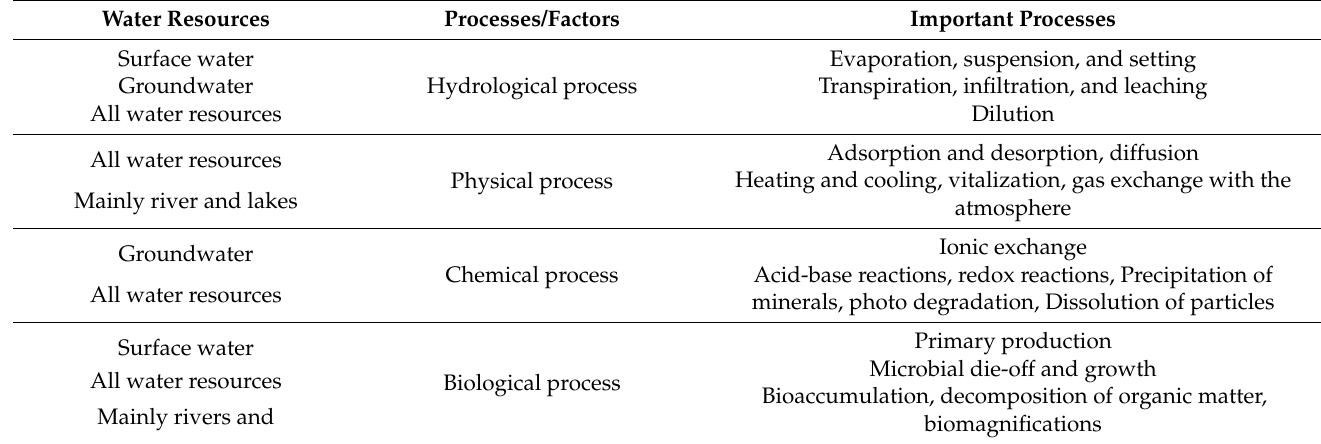
Table 2. Most crucial natural factors/processes which affect water quality.